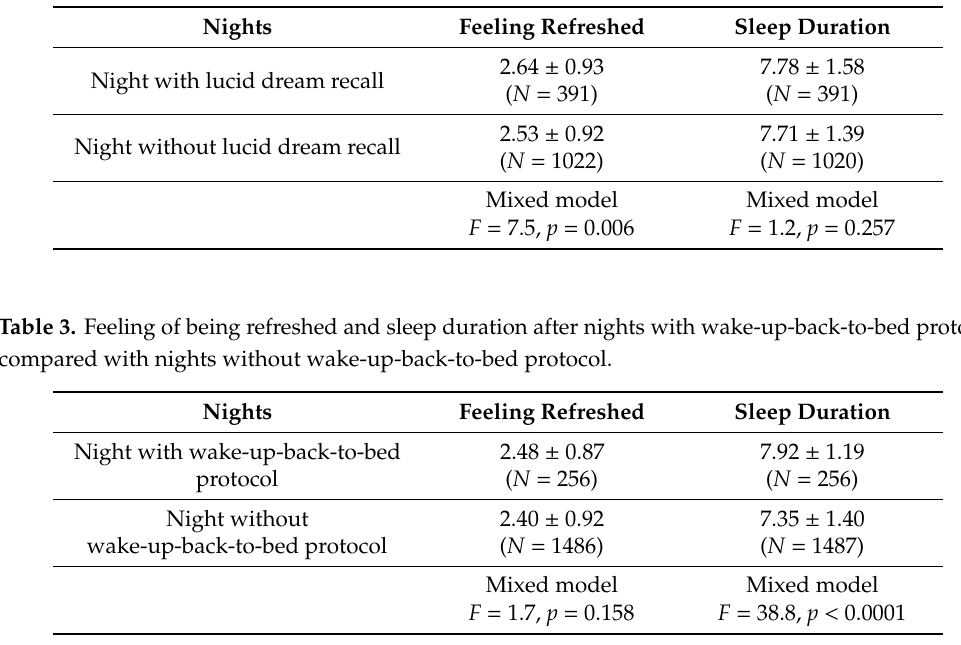
Table 2. Feeling of being refreshed and sleep duration after nights with lucid dream recall compared with nights without lucid dream recall.